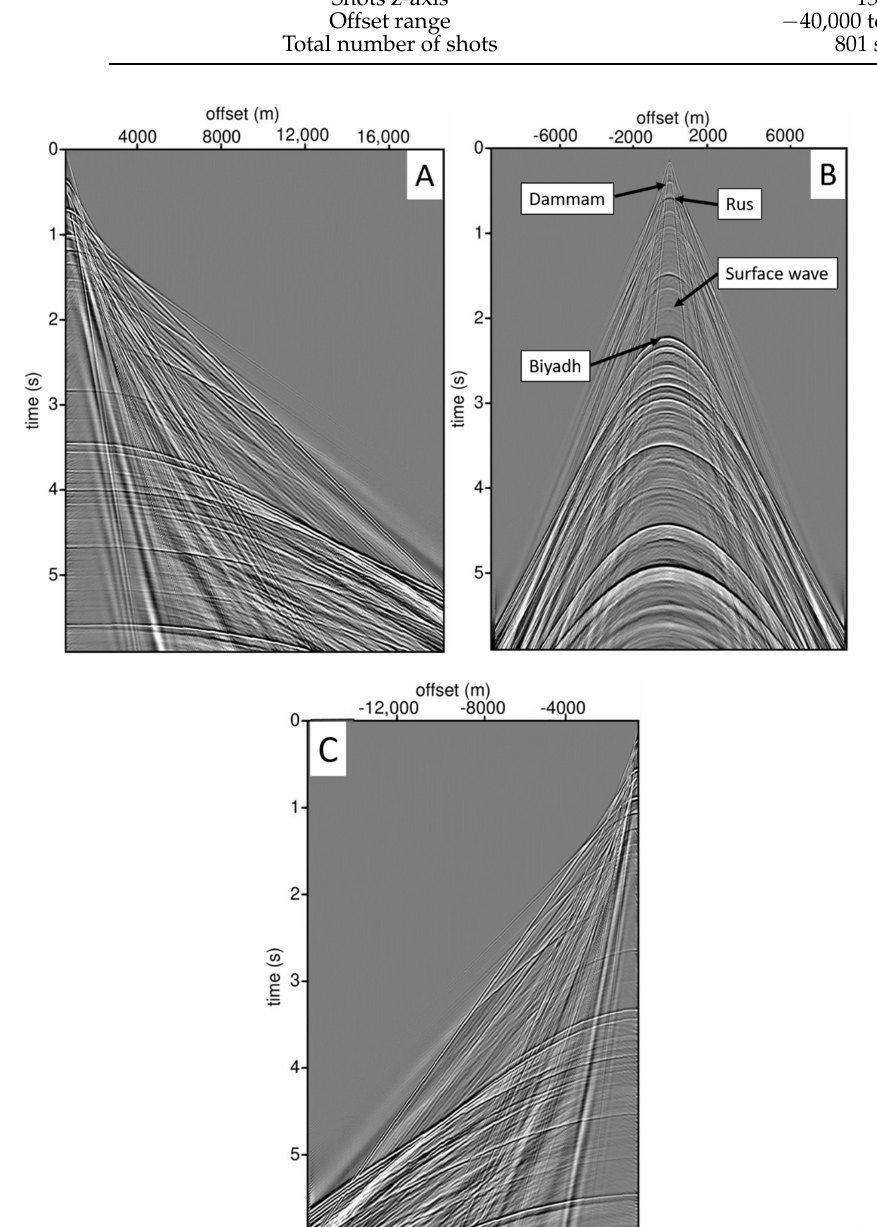
Figure 6. Vertical component of synthetic seismic data for shot located at ( A ) x = 1 m, ( B ) x = 2000 m, and ( C ) x = 40,000 m. Some prominent seismic events are indicated on ( B